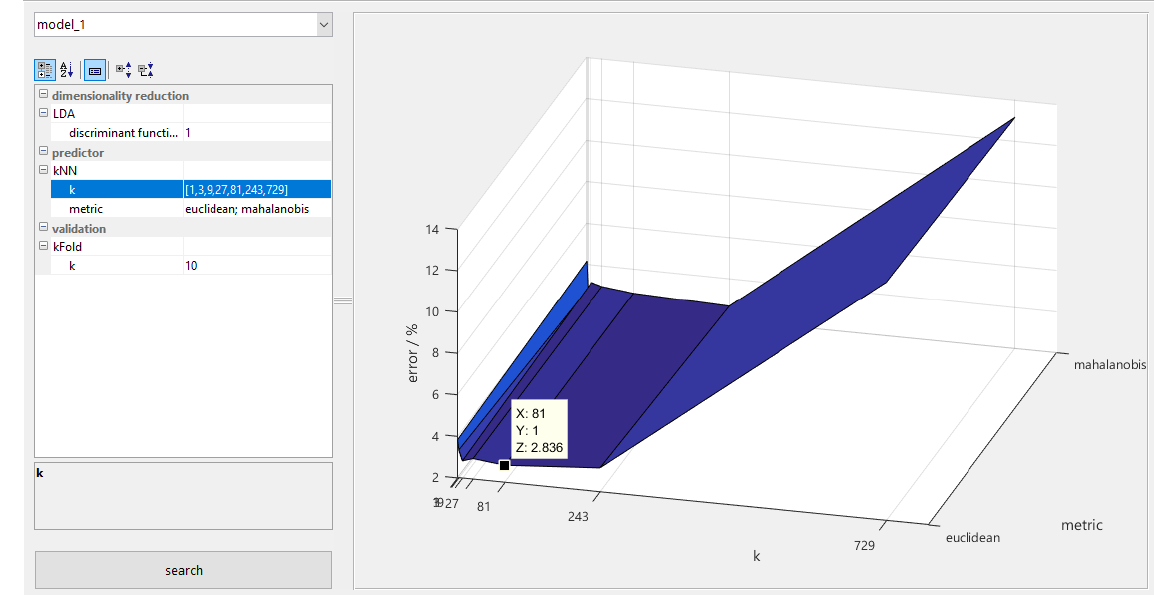
Figure 11. The grid search module lists all parameters of a particular model and accepts valid MATLAB expressions as their values, so lists of values can be given for each parameter. The automated grid search evaluates the model for all permutations of parameter values and plots the model error dependent on parameter values, highlighting the optimum